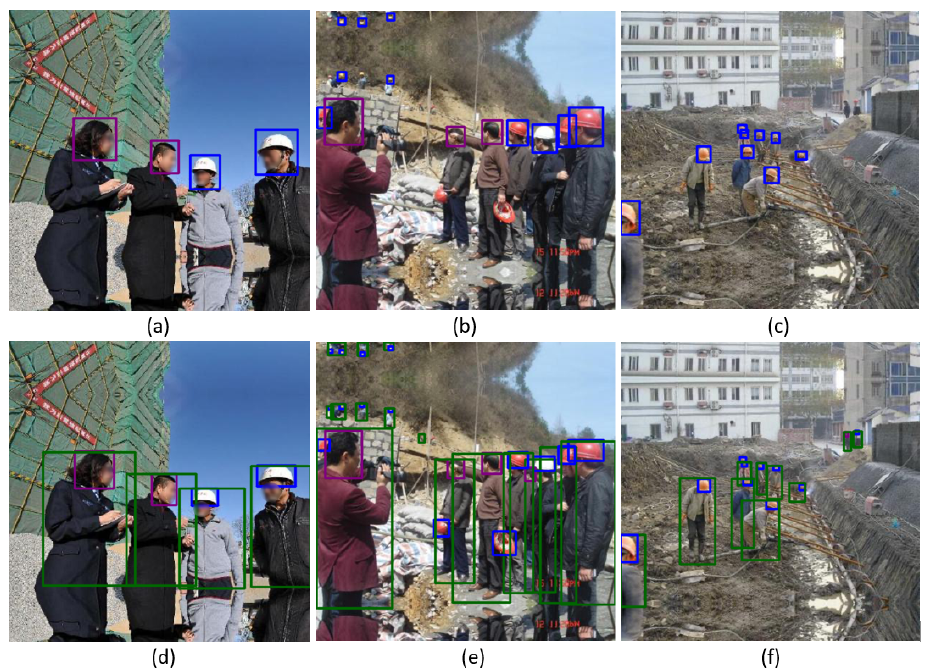
Figure 5. Comparison of the SHD and SHEL5K dataset results on the same images. ( a – c ) The results of the best SHD dataset [8] model. ( d – f ) The results of the best SHEL5K dataset